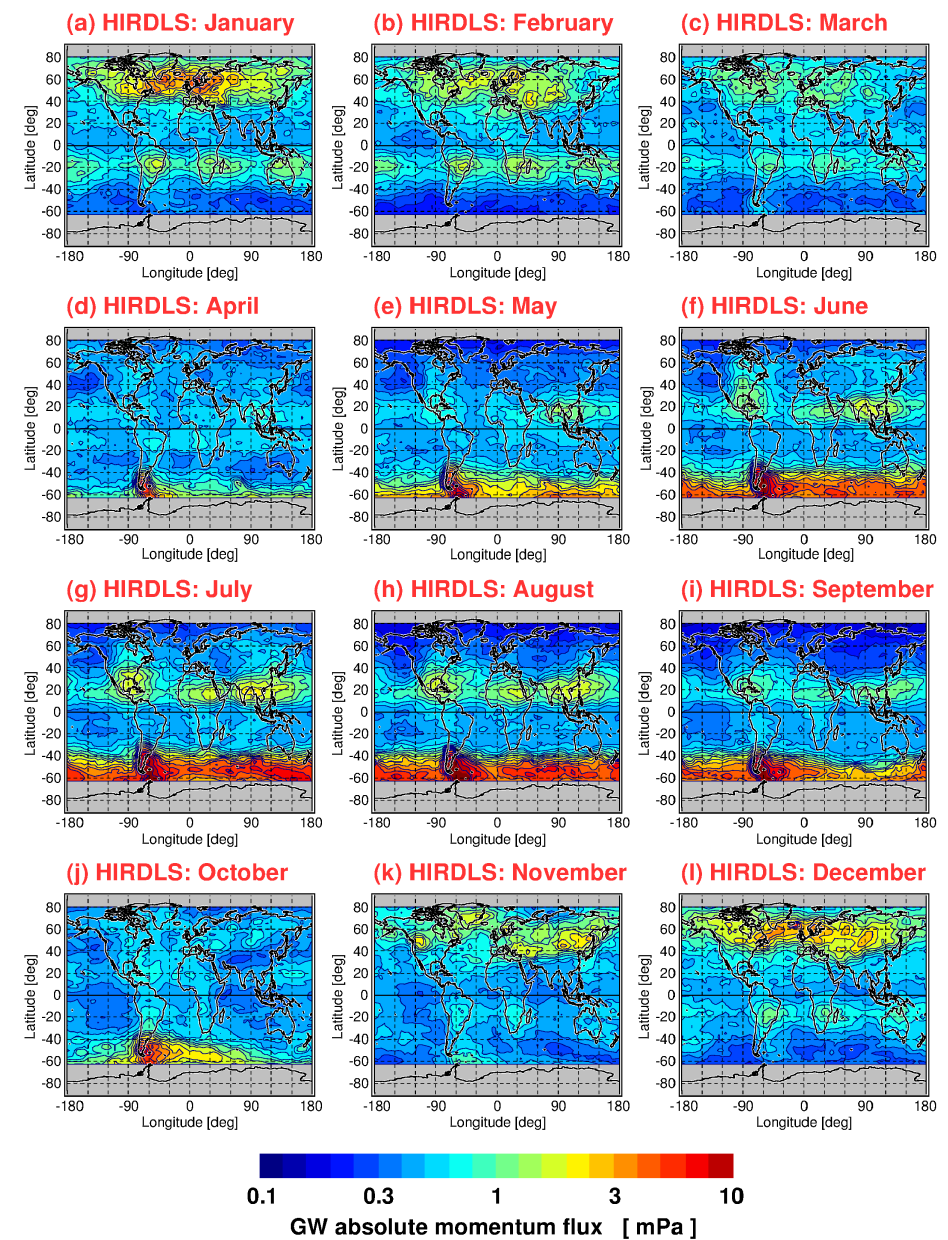
Figure 14. Same as Fig. 13 but for 3-year averages of the HIRDLS instrument at 30km altitude.